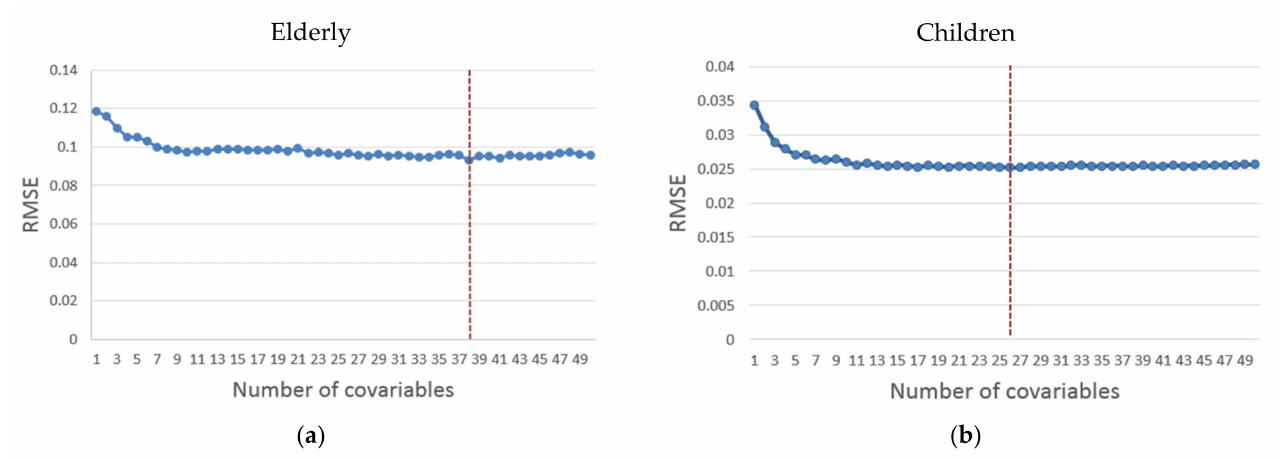
Figure 4. The relationship between different root mean square error (RMSE) values and the optimal subset of different numbers of variables ( a ) for the elderly subset and ( b ) for the child subset. (The red lines represent the minimum RSME of the model based on different optimal subsets, indicating that the variable numbers of the optimal subset of elderly and children were 38 and 26,